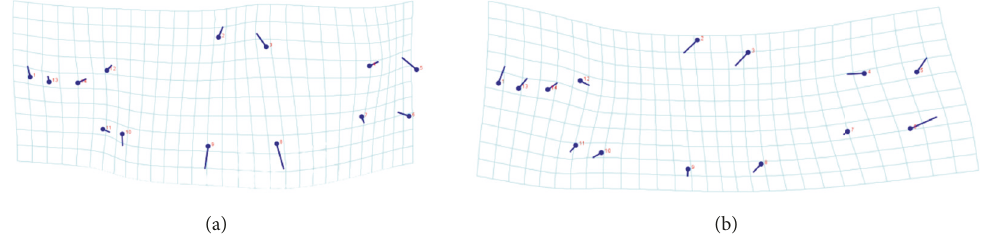
Figure 4: Consensus shape for each species. (a) Astyanax rivularis ; (b) Astyanax paranae . The dot represents the landmarks and the trace of the direction where the landmarks are moving in the deformation